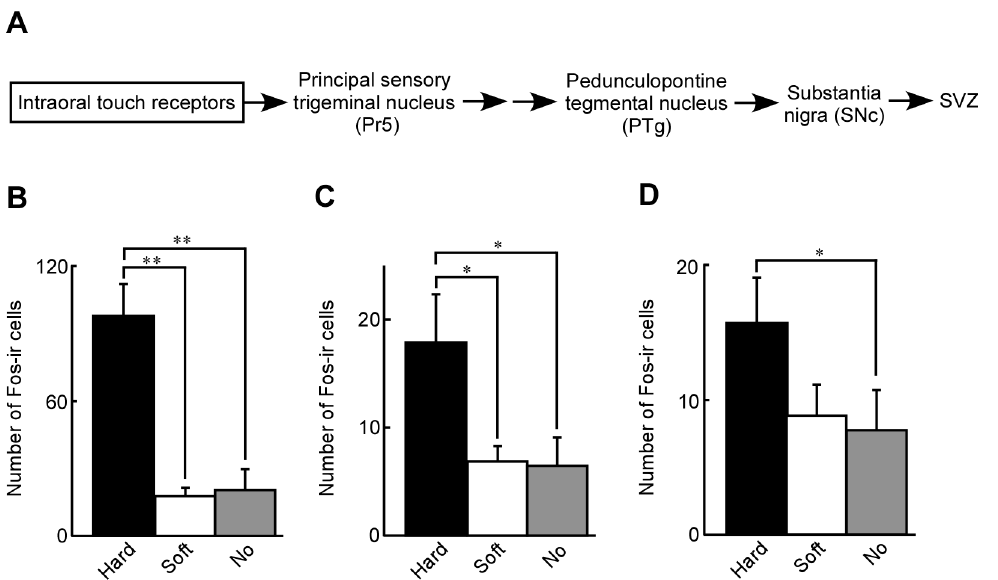
Figure 5. Effects of a hard or soft diet on the expression of Fos-ir cells in Pr5, PTg and SNc. A: A schematic transmission pathway of oral sensation from the mouth to the SVZ. The principal sensory trigeminal nucleus (Pr5), which receive intraoral touch information via the trigeminal nerve, transmits to the pedunculopontine tegmental nucleus (PTg) via the thalamus [24], somatosensory cortex [25], and motor cortex [26]. Neurons of the PTg innervate to the substantia nigra pars compacta (SNc) [27,28,47], in which dopaminergic neurons innervate to the SVZ [29,30]. The number of Fos-ir cells in 100 m m thickness in Figure 115 of the mouse atlas (lateral 1.68 mm) of the Pr5 (B), 100 m m thickness in Figure 111 of the mouse atlas (lateral 1.20 mm) of PTg (C), and 200 m m thickness from Figure 106 of the mouse atlas (lateral 0.60 mm) of SNc (D) to the lateral side of mice after the ingestion of a hard diet (black column), soft diet fed (white column) or no diet (gray column). n=4 (white and gray column in B). n=5 (C). n=10 (black and gray column in D). n=11 (white column in D). *: p , 0.05; **: p , 0.005.